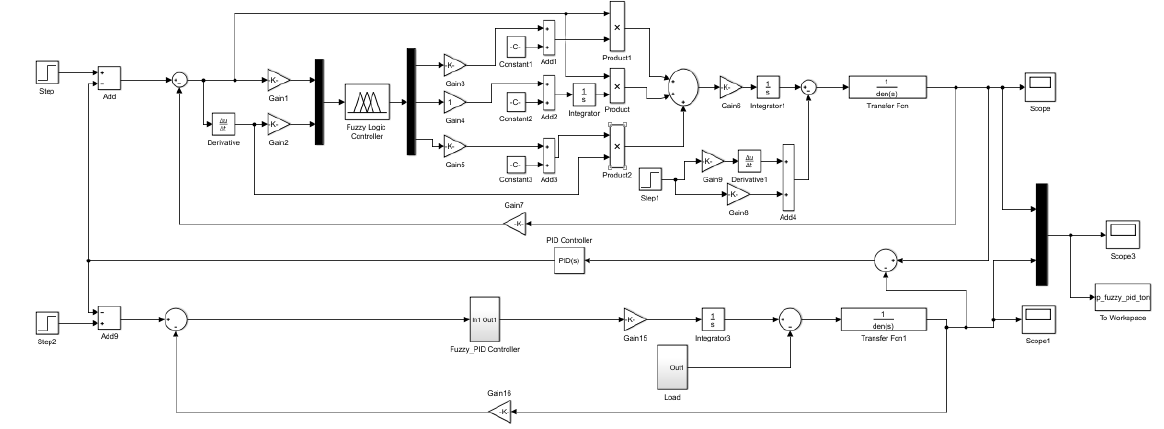
Figure 10. Fuzzy PID simulation model.